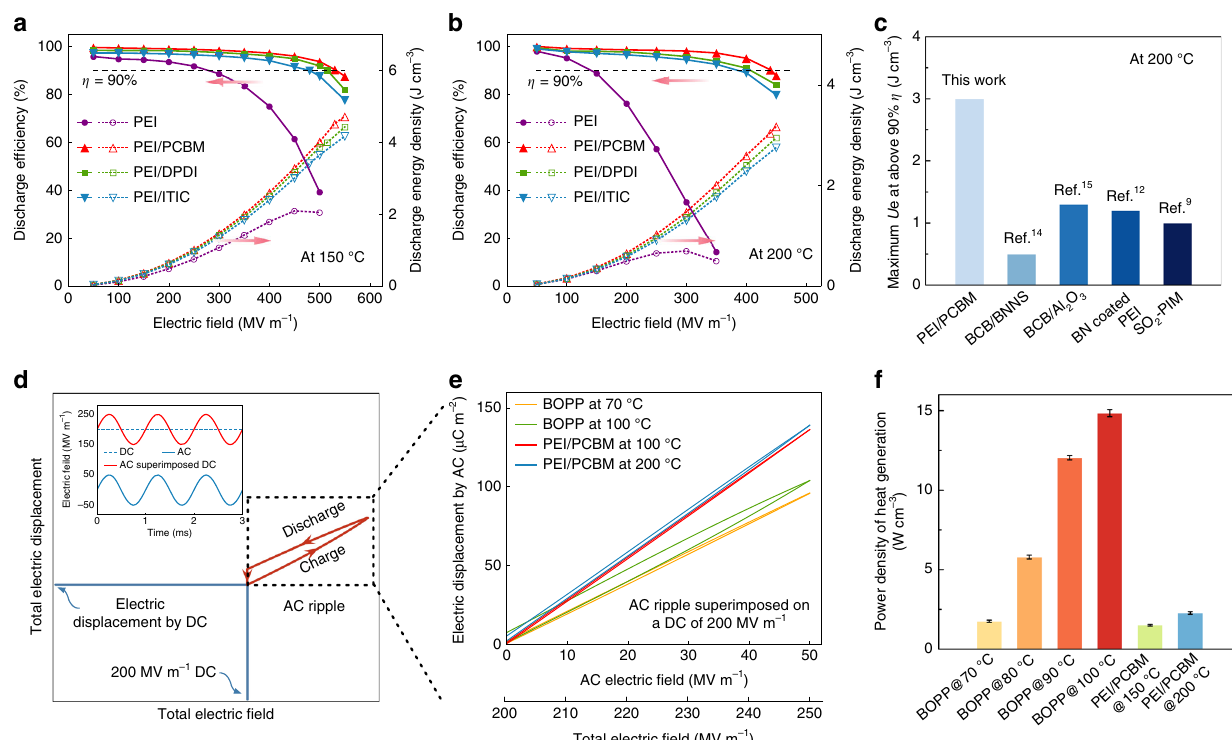
Fig. 3 Electric energy storage capability. a , b Field-dependent energy density and discharge ef fi ciency of PEI and PEI/PCBM (0.5 vol.% PCBM), PEI/DPDI (0.75 vol.% DPDI), and PEI/ITIC (0.25 vol.% ITIC) composites at ( a ) 150 °C and ( b ) 200 °C. c Comparison of maximum discharged energy density